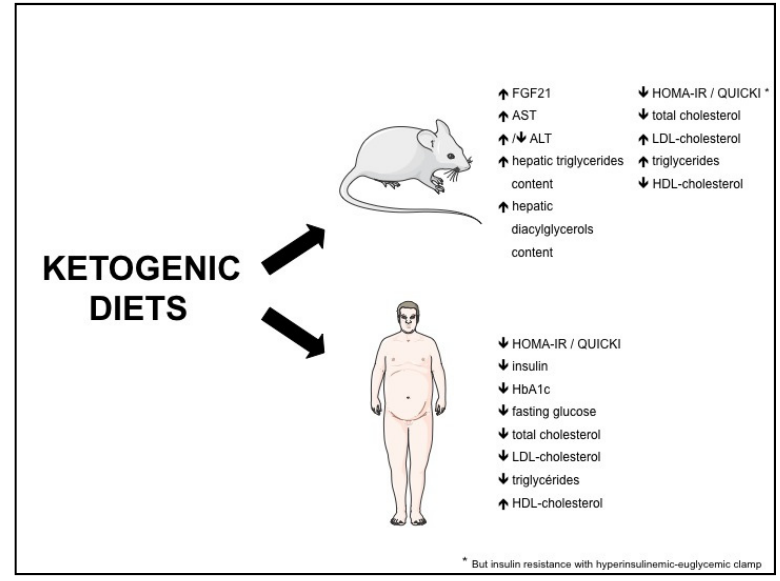
Figure 2. Effects of ketogenic diets on biomolecular markers. FGF21: fibroblast growth factor-21; ALT: alanine aminotransferase; AST: aspartate aminotransferase; QUICKI: quantitative insulin-sensitivity check index; HOMA-IR: homeostasis model assessment of insulin resistance.